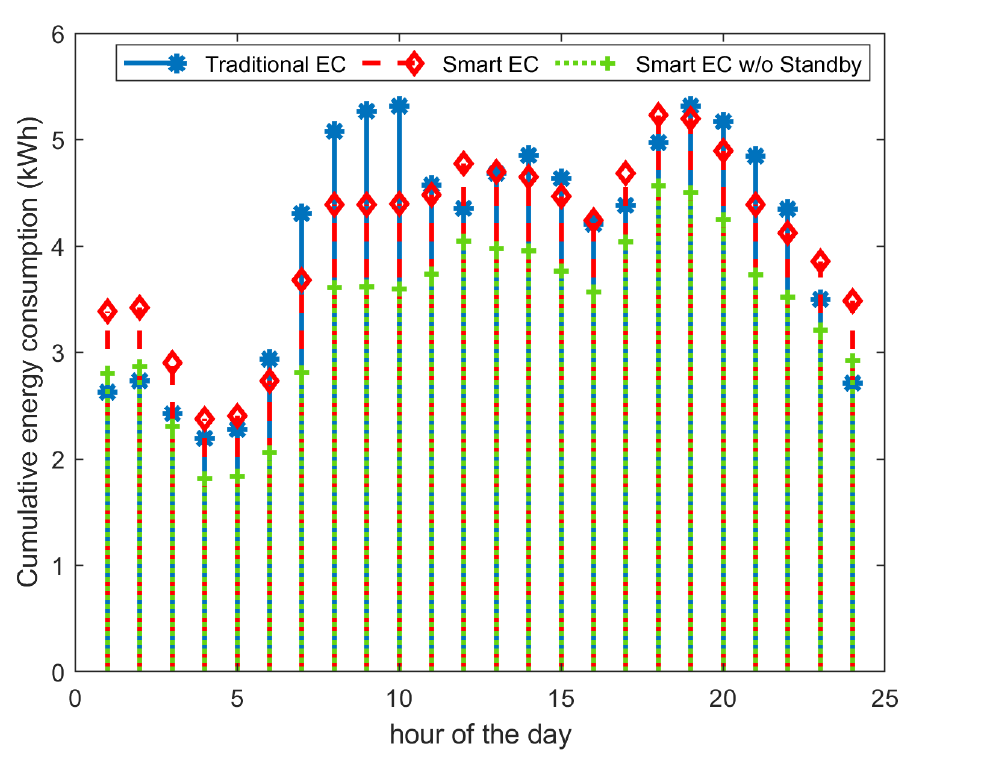
Figure 10. The mean of the cumulative energy consumption of 17 homes over 30 days in June 2014: Traditional and Reinforcement Learning. The RL approach succeeded in shaving the peaks and levelling the